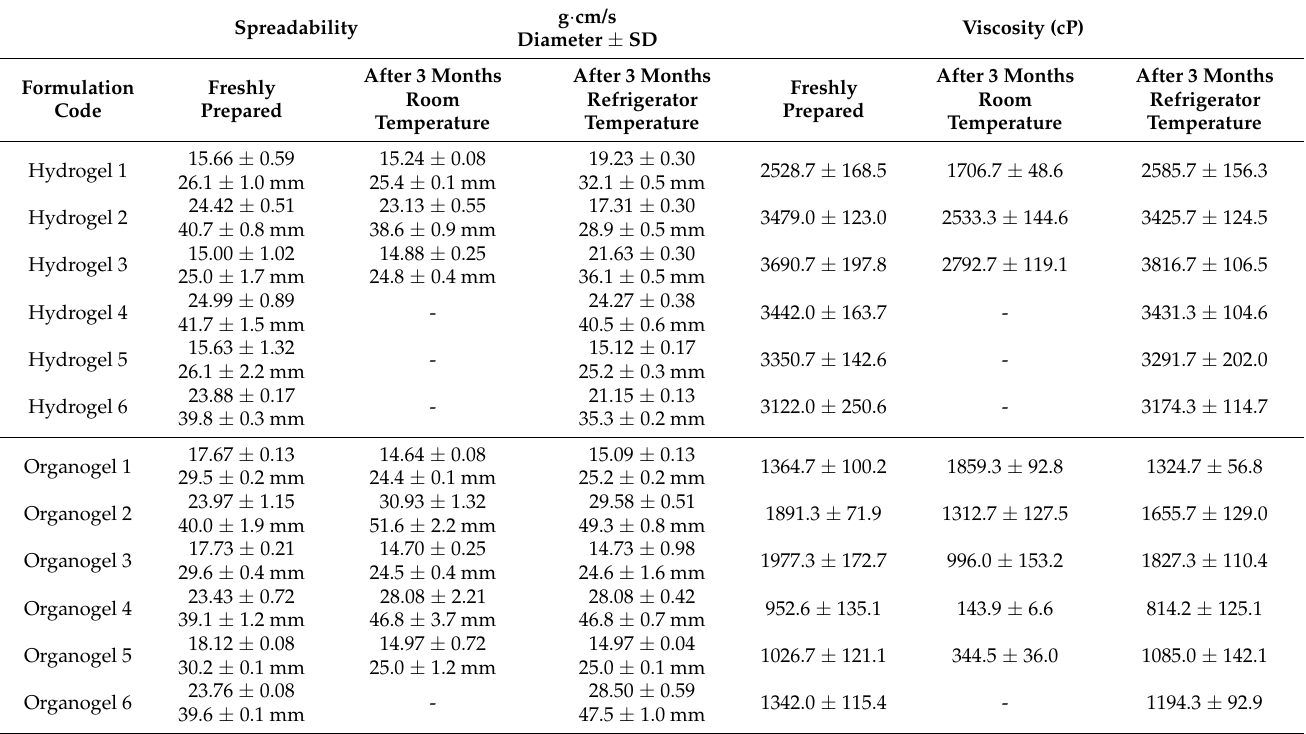
Table 6. The spreadability and viscosity results of hydrogels and organogels (mean ±